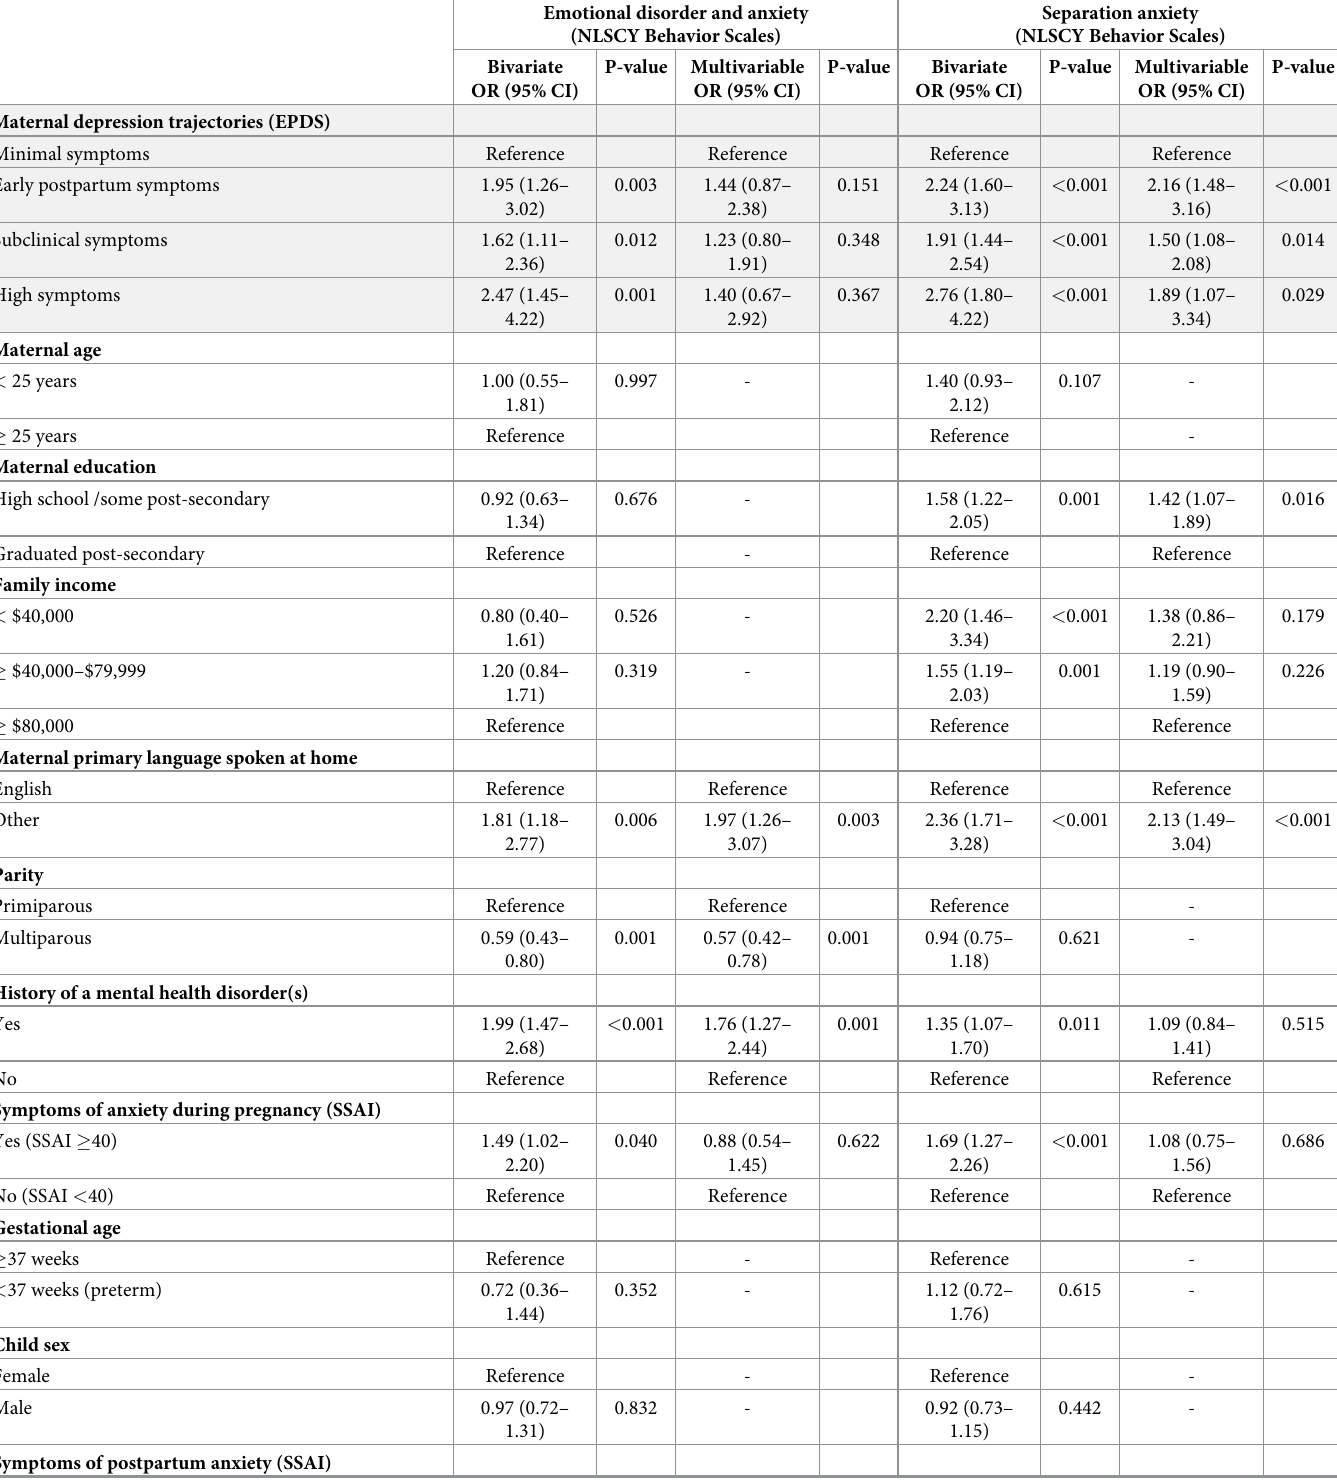
Table 6. Bivariate and final multivariable logistic regression model predicting children’s Internalizing behaviors (emotional/anxiety disorder and separation anxi- ety) at age